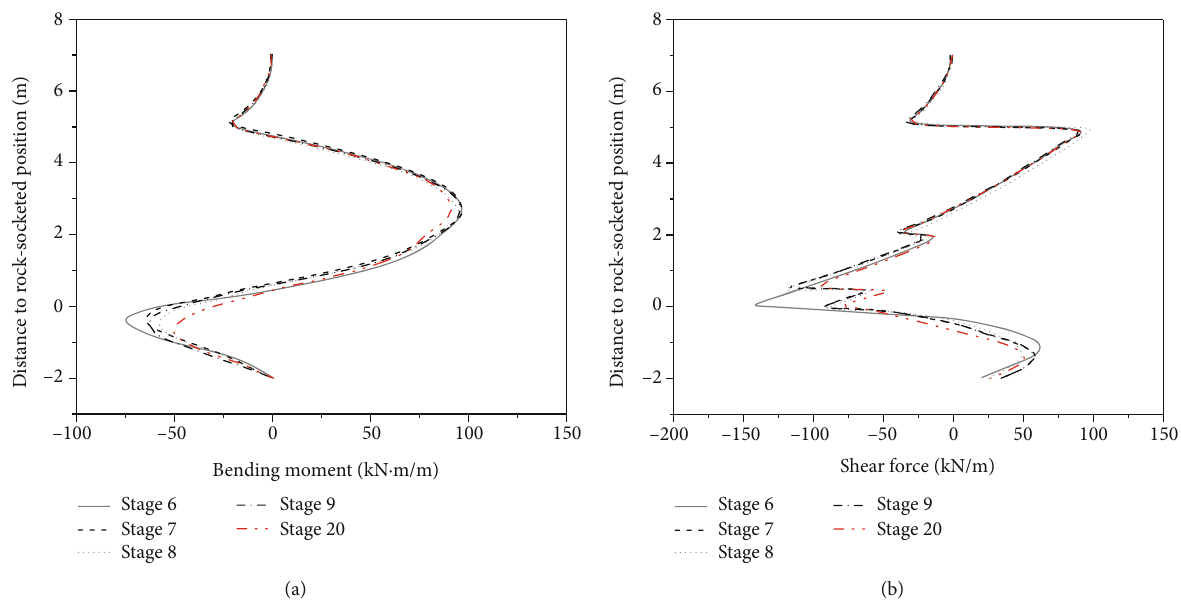
Figure 15: Variation of internal forces in the end-suspended pile with the construction stage. (a) Bending moment. (b) Shear Figure 14. It can be noted that the horizontal pile tip displace- ment increased with an increase in the excavation depth.